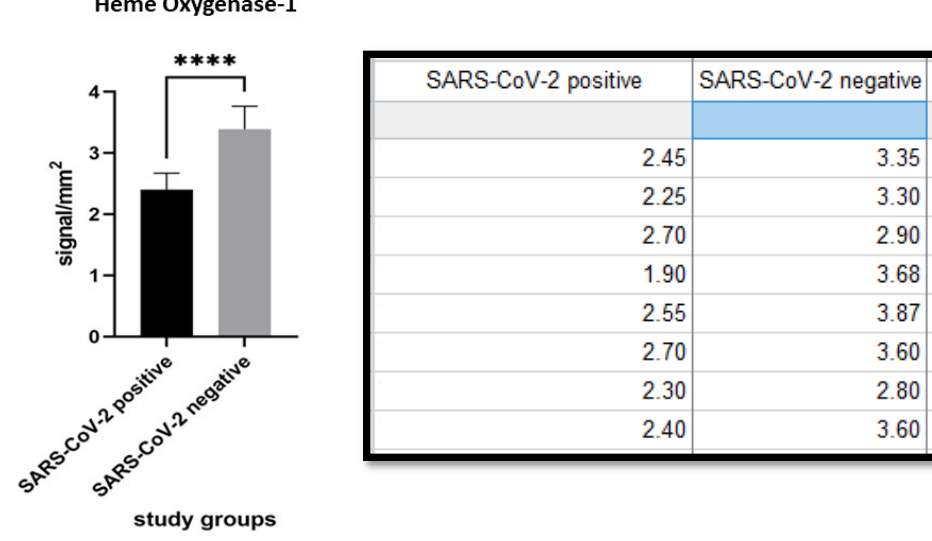
Figure 9. Comparison of immunoexpression for HO-1 between the two populations. Note the statistically significant difference ( p value < 0.0001). **** statistic significative